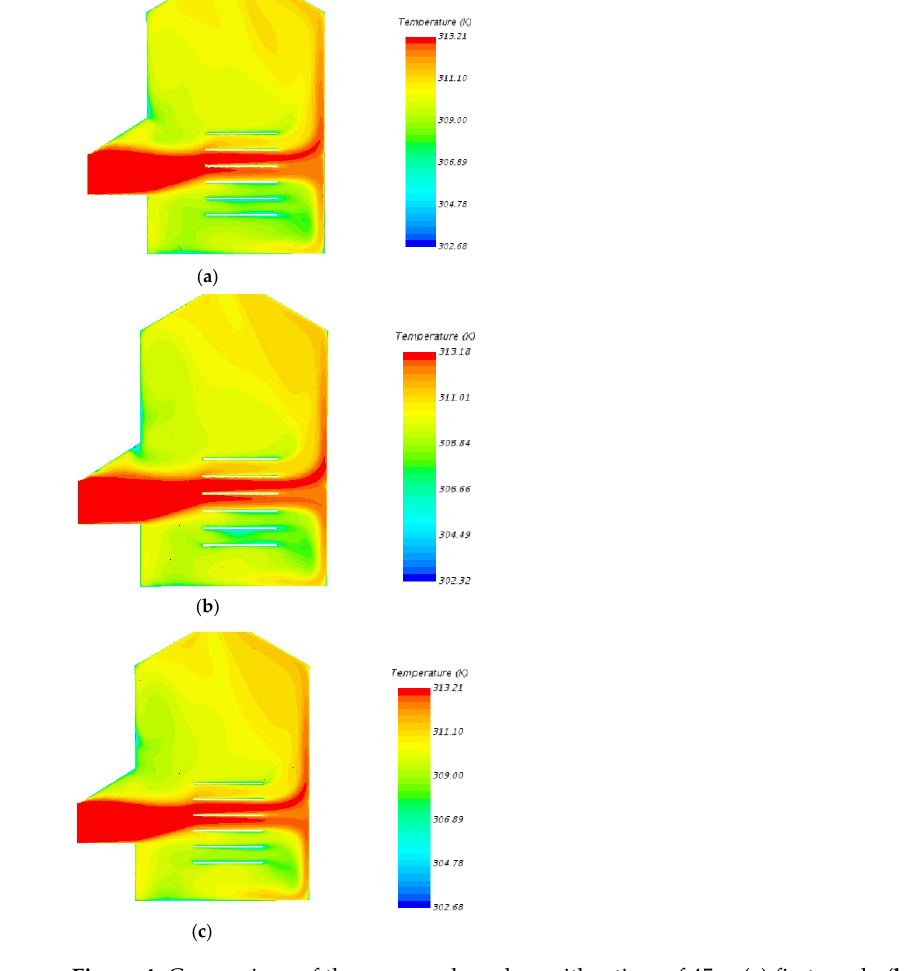
Figure 4. Comparison of the proposed meshes with a time of 45 s: ( a ) first mesh, ( b ) second mesh, and ( c ) third mesh. As can be seen, the temperature results do not vary significantly. The volume average temperature was 308.37 K, 310.288 K, and 310.856 K calculated for meshes 1, 2, and 3, respectively. Nevertheless, an increase in computational time is seen. For the 45 s that the simulation was run on a 10-core computer, an estimated 51.4, 127.23, and 238.23 h were calculated for meshes 1, 2, and 3, respectively. With these results, the chosen mesh was the second one. The third one had a significant increase in computational time, while the first one had an unappropriated cell size for the total length of the chamber. 3.2. Model Validation The data validation was made by comparing the experimental data at the exit of the chamber in a drying procedure and the simulation data in the exact location. It is essential to mention that the data compared were only the ones corresponding to the time after the air temperature has stabilised since it includes food samples, and this affects the air temperature significantly at the beginning of the process due to changes in the relative humidity of the air, delaying the time to achieve temperature stabilisation. Comparison between experimental and simulated data are plotted in Figure 5. Due to the lack of samples and stability in relative humidity, the time to achieve a constant air tem- perature is noticeably faster than for the experimental data, as was explained before. It is also shown that the numerical data tend to have the same values as the experimental ones. Figure 5. Comparison between experimental and numerical data.